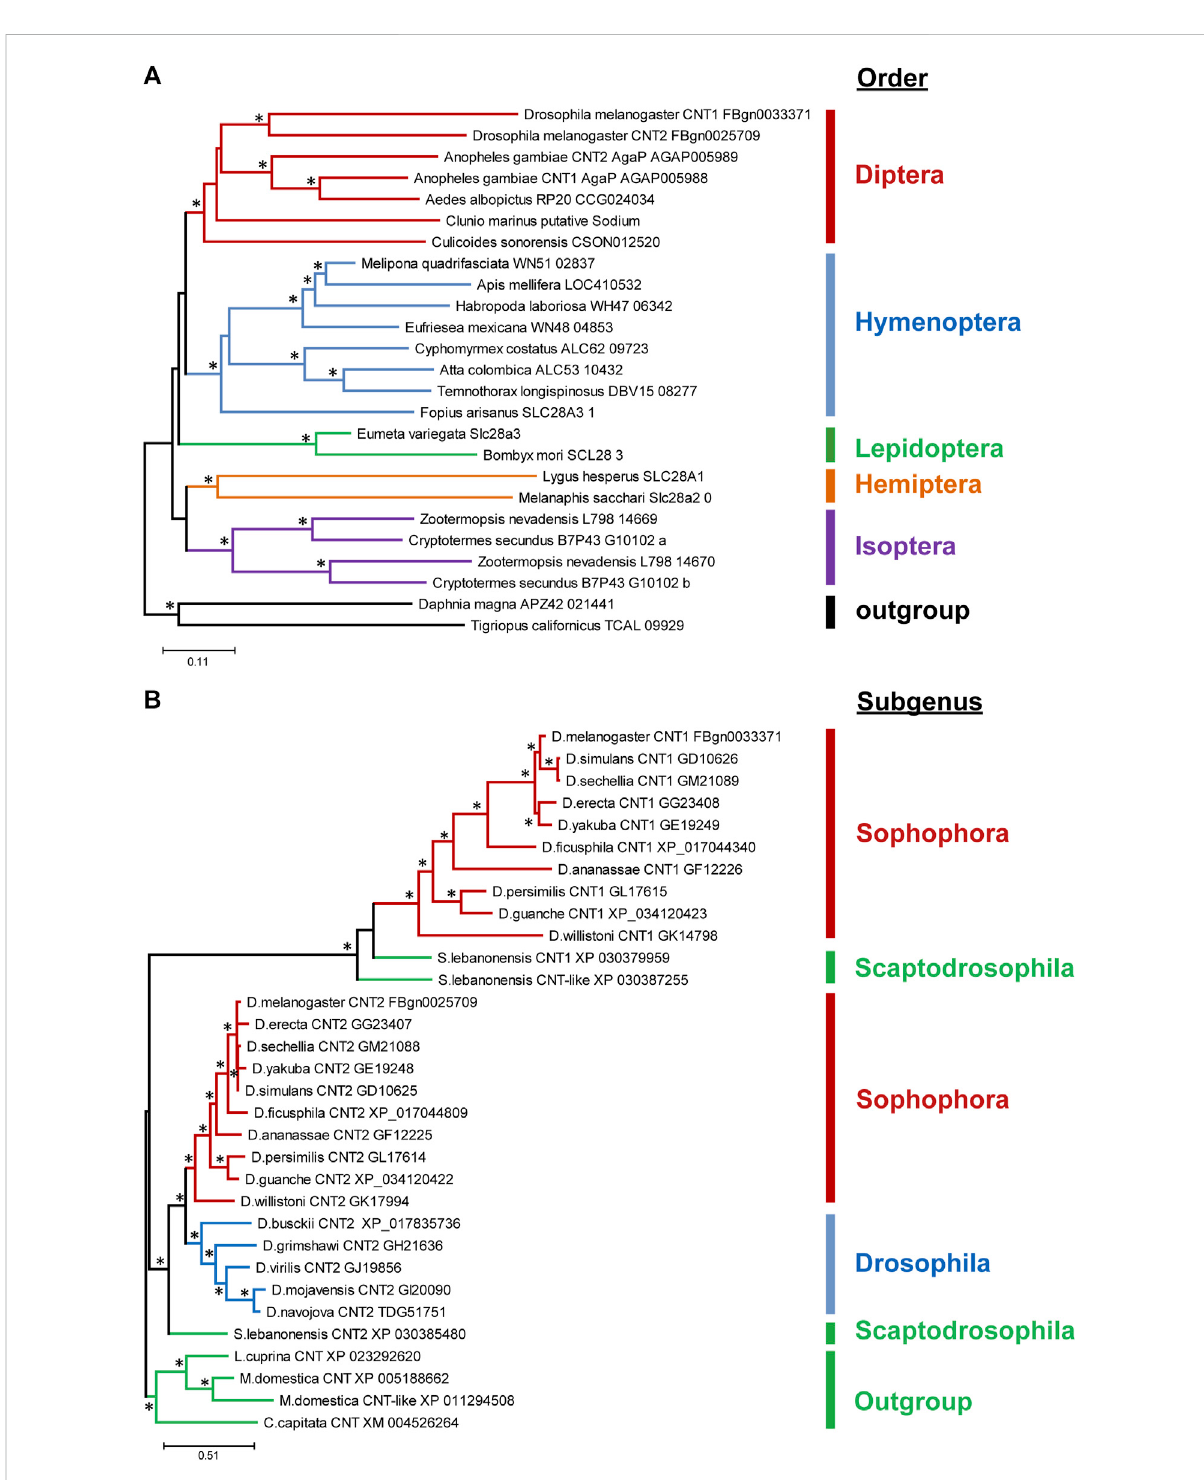
FIGURE 1 Distribution of Cnts in insects and family drosophilidae. (A) Simpli fi ed phylogenetic tree of Cnts among insects. Each color represents a particular order of insects. (B) Simpli fi ed phylogenetic tree of Cnt in Drosophila . Each color represents a subgenus of Drosophila . Branches with statistical support (aBayes values) greater than 70 are marked with